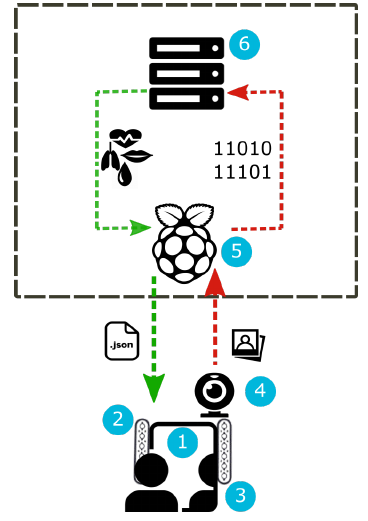
Figure 1. Hardware